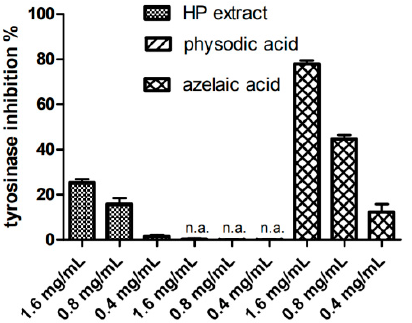
Figure 4. Inhibition of tyrosinase by Hypogymnia physodes extract (HP extract), physodic acid and